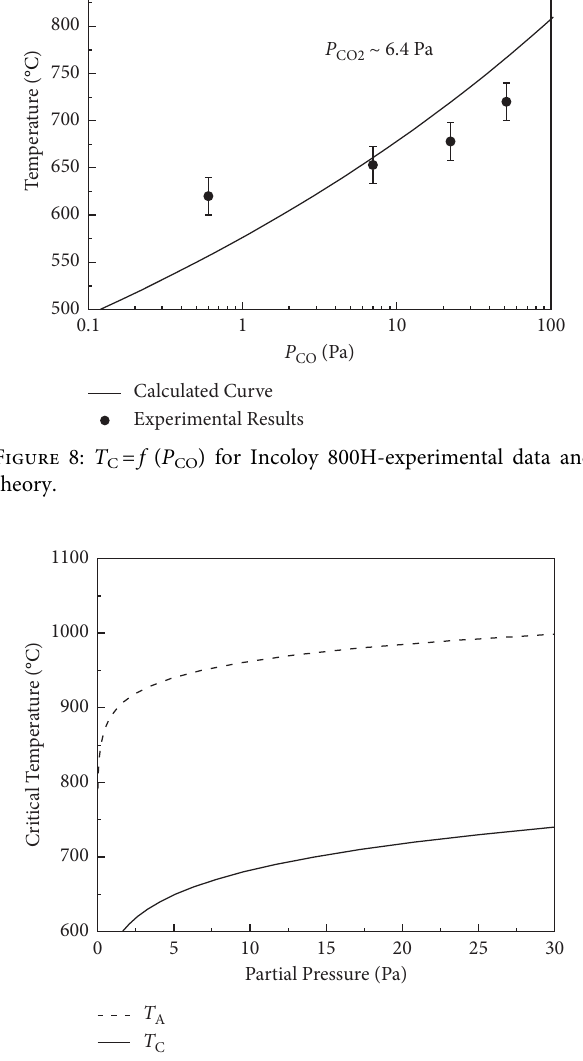
� P (CO) for Incoloy 800H-experimental data and